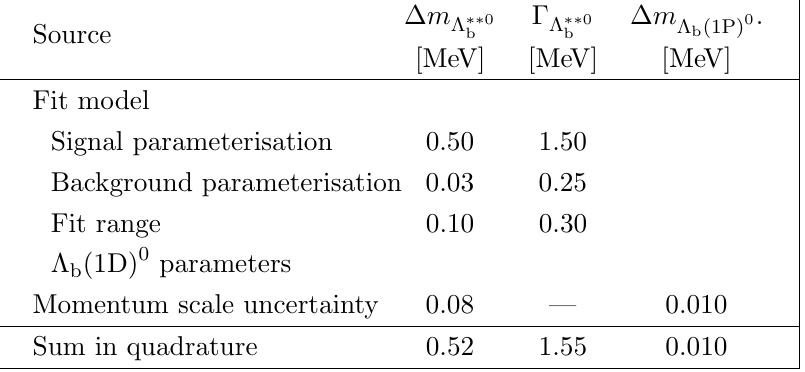
Table 4 . Summary of systematic uncertainties for the mass di(cid:11)erence with respect to the ground state (cid:3) 0 and natural width of the (cid:3) (cid:3)(cid:3) 0 b